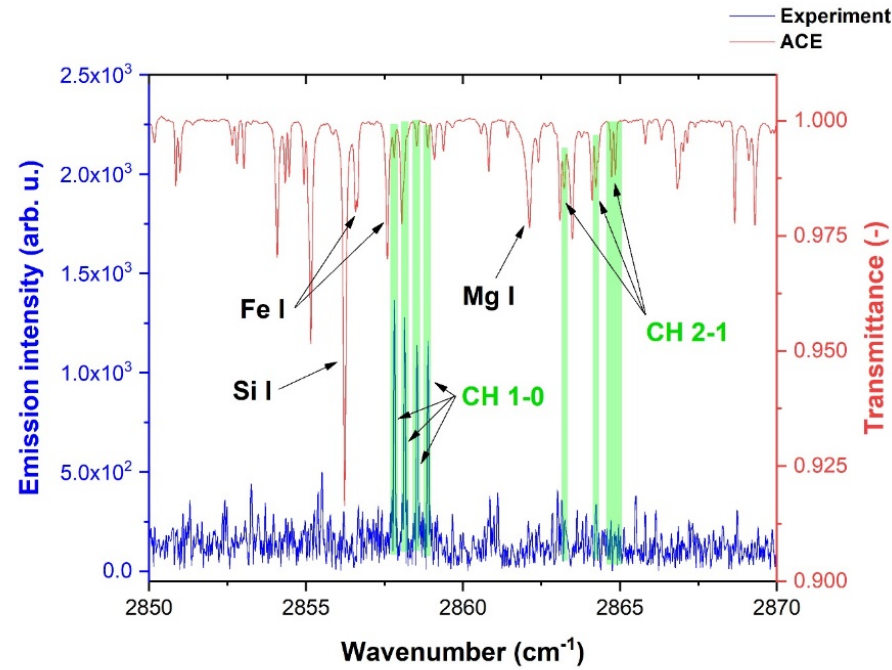
Figure 30. The time pro fi le of CH radical at 2858 cm − 1 . The time interval of the discharge pulse is marked in yellow.